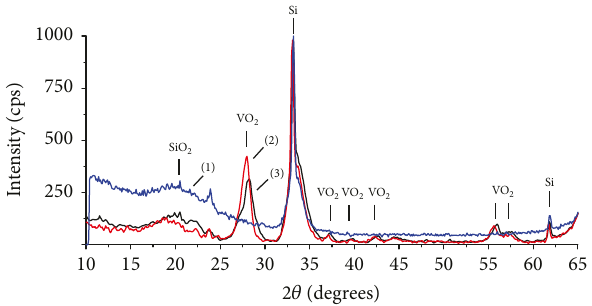
Figure 3: XRD patterns of Si substrate (1) , initial VO 2 film on silicon (2) , and VO 2 film after hydrogen implantation.